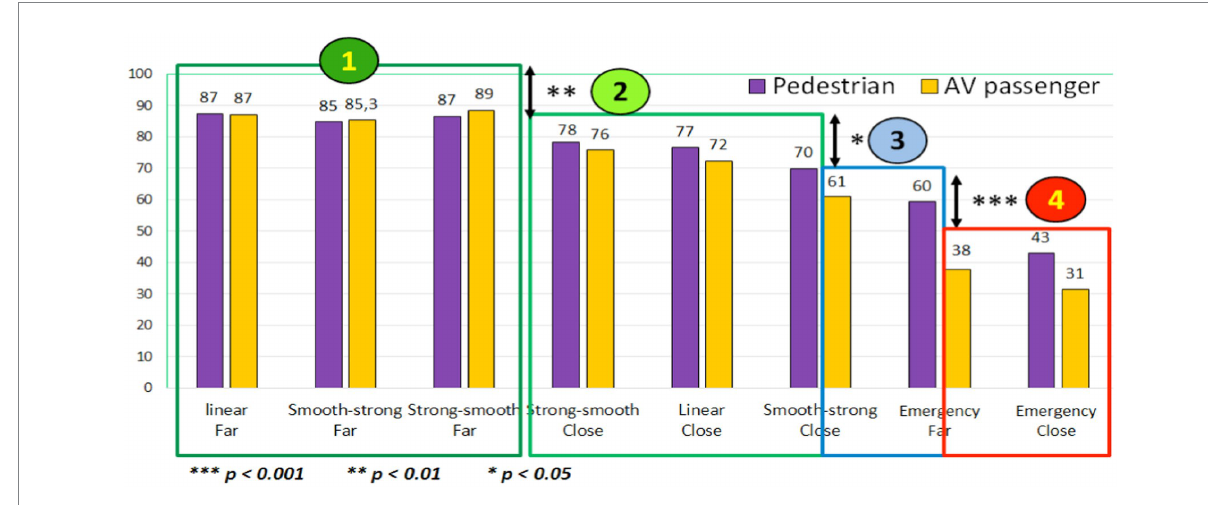
FIGURE 9 Participants’ evaluations about the safety of different AV behaviors to yield, from the pedestrian and the AV passenger point of views.